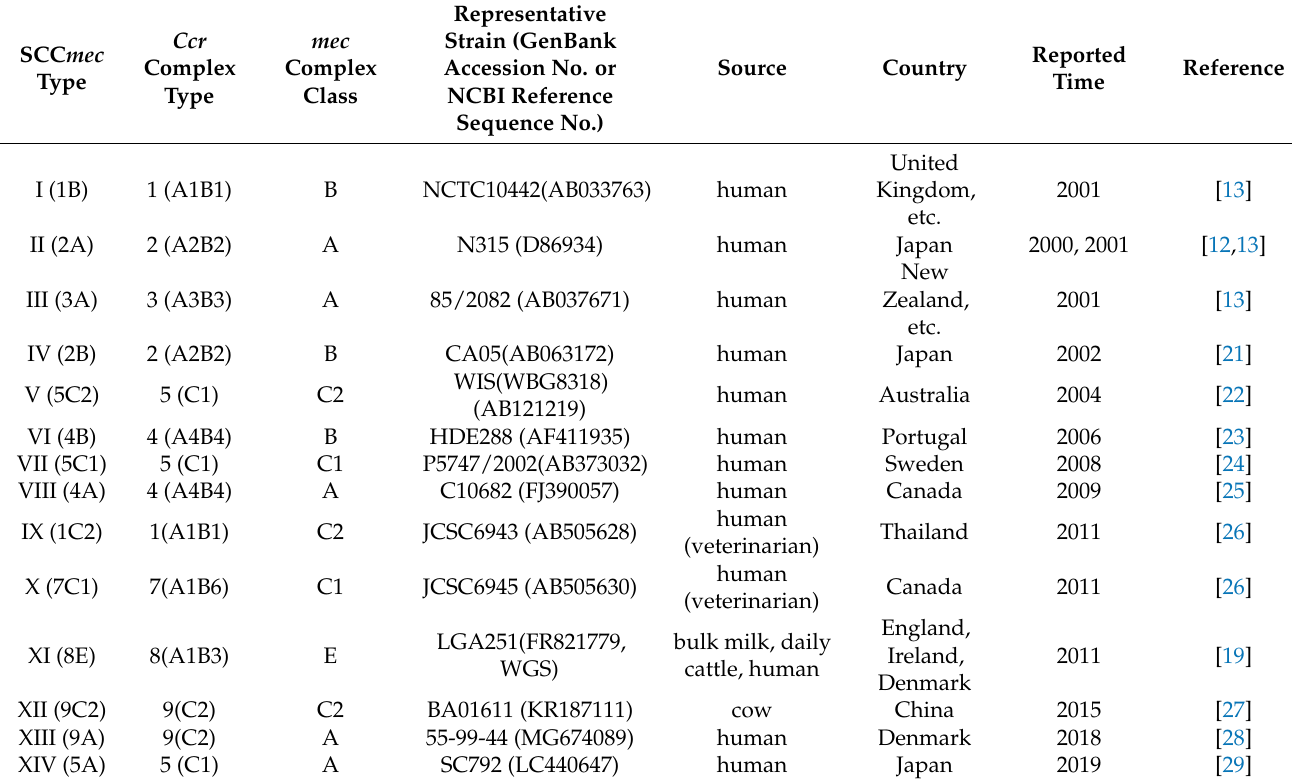
Table 2. Current SCC mec types (14 December